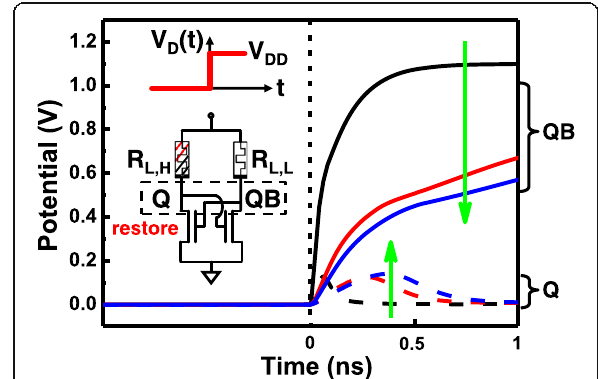
Fig. 11 Restoration of the non-volatile data stored into Q and QB